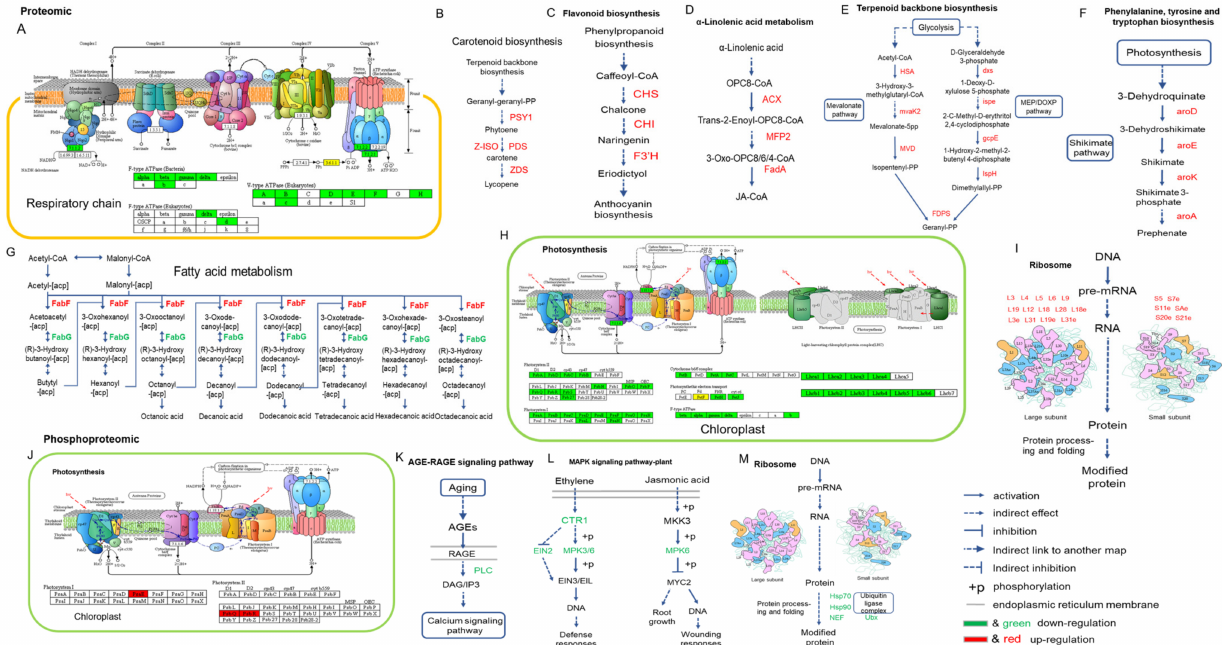
Figure 10. Schematic diagram of representative DEPs and DEPPs in metabolic pathways during fruit-ripening. ( A ) Respiratory chain, ( B ) Carotenoid biosynthesis, ( C ) Flavonoid biosynthesis, ( D ) α -linolenic acid metabolism, ( E ) Terpenoid synthesis, ( F ) Phenylalanine, tyrosine and tryptophan biosynthesis, ( G ) Fatty acid metabolism, ( H ) Photosynthesis, ( I ) Ribosome assembly, ( J ) Photosynthesis (Phosphoproteomic), ( K ) AGE-RAGE signaling pathway, ( L ) MAPK signaling pathway, ( M ) Ribosome assembly (Phosphoproteomic). The metabolic pathways are constructed from on proteomics and phosphoproteomics data. The red fonts represent up-regulation, green fonts represent